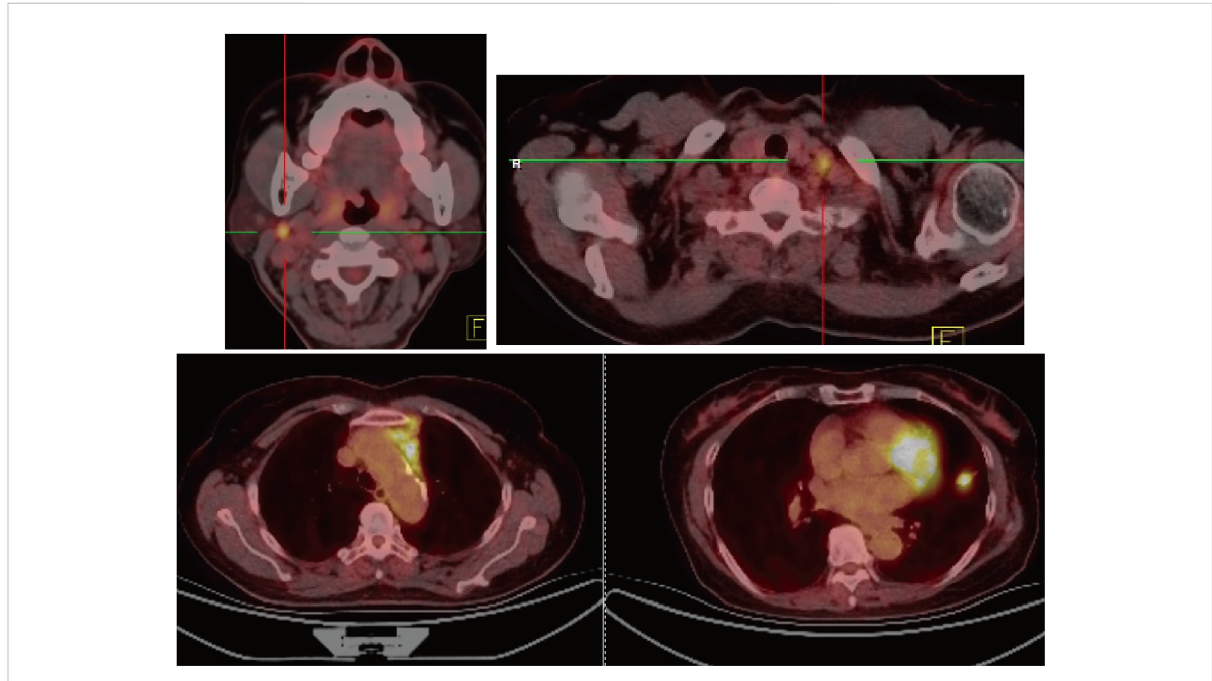
1). Fine-needle aspiration biopsy on the supraclavicular lymph node revealed metastatic adenocarcinoma, and lung nodule biopsy con fi rmed PD-L1- negative lung adenocarcinoma. Reverse